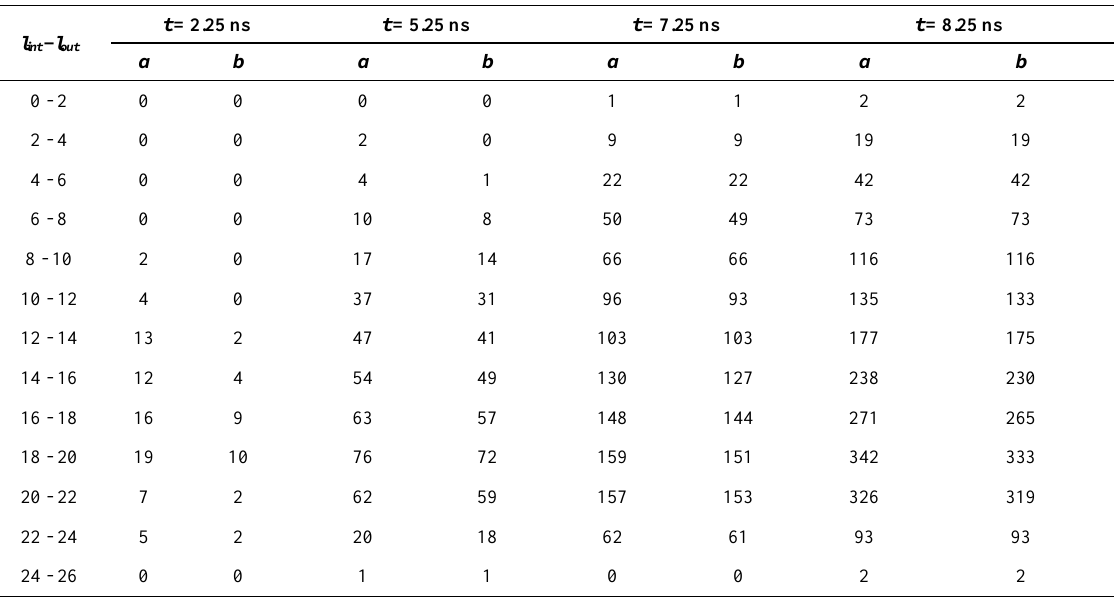
Table 2. Distribution of G3-atoms through different spherical layers for 5000 atoms sample at 900 K: a ) all G3-atoms; b ) the G3-atoms of main cluster